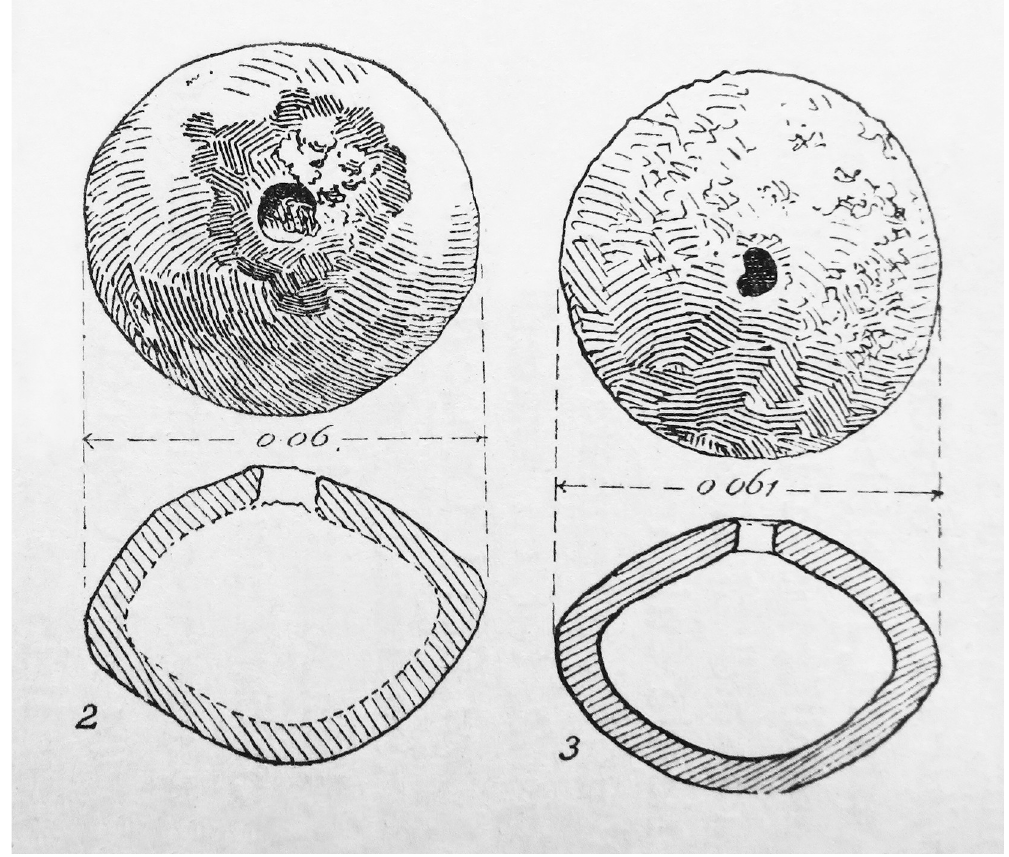
Fig 10. Bleje ş ti, left: no. 1–2, right: 1–1 (after Berciu 1948).